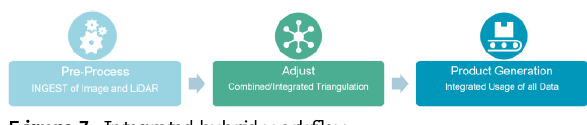
Figure 7: Integrated hybrid workflow